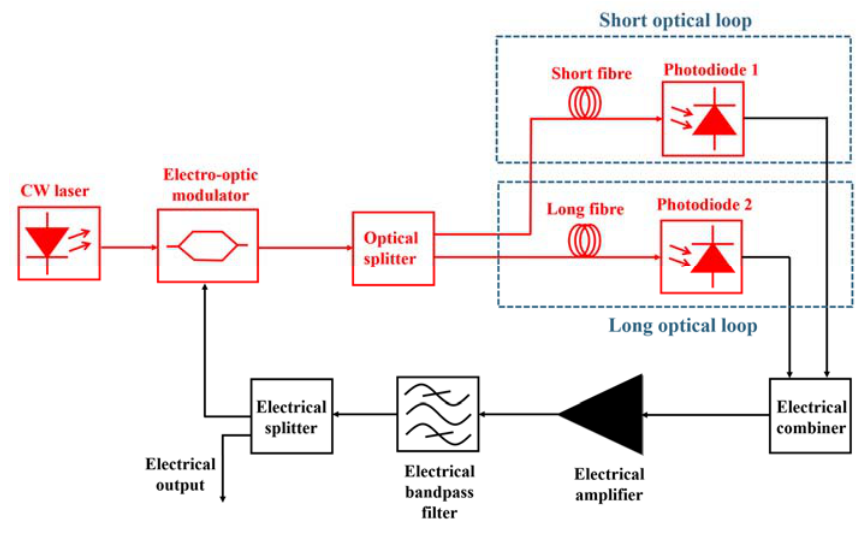
Figure 3. Typical dual-loop configuration of an OEO.